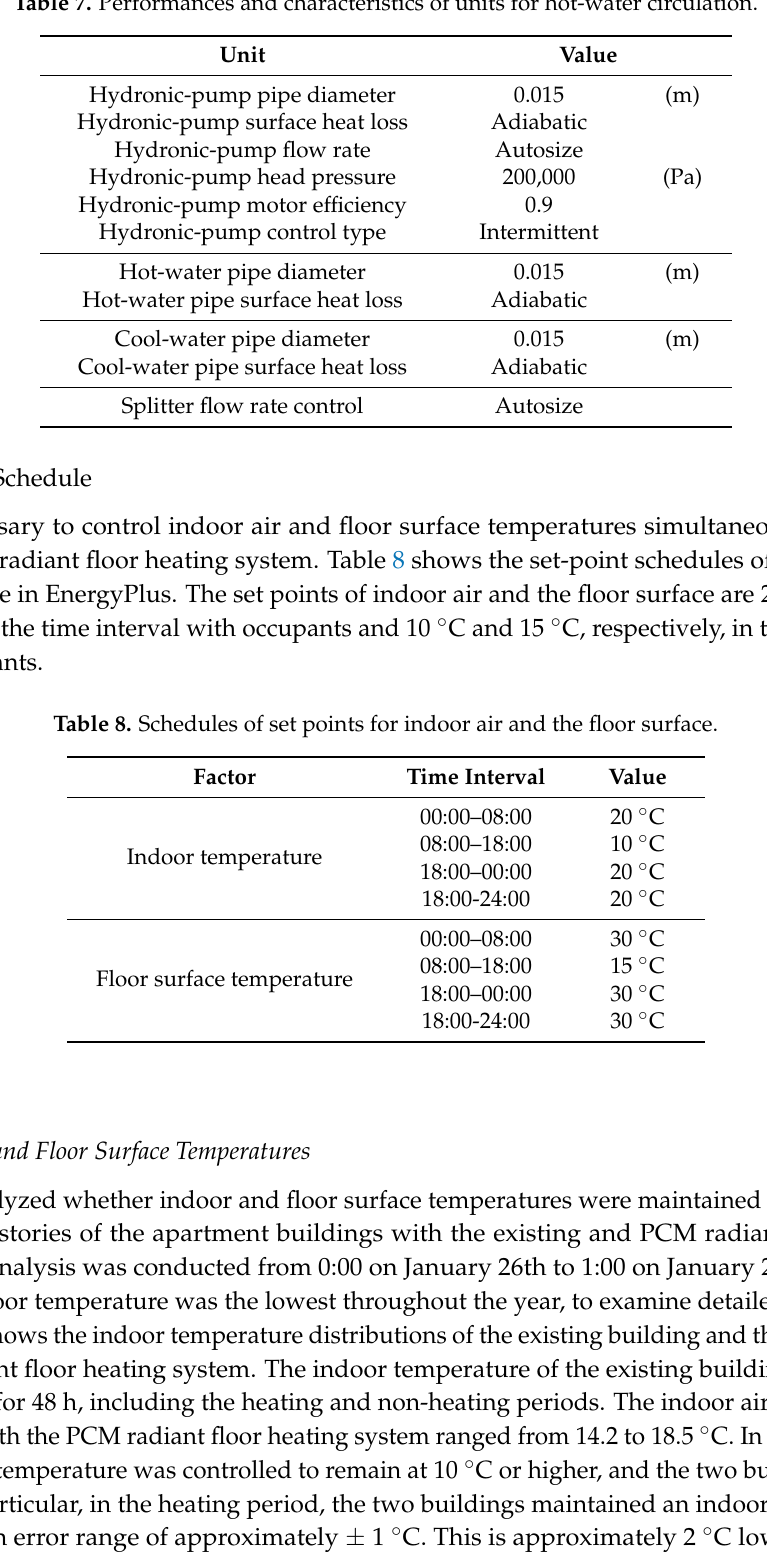
Table 7. Performances and characteristics of units for hot-water circulation.